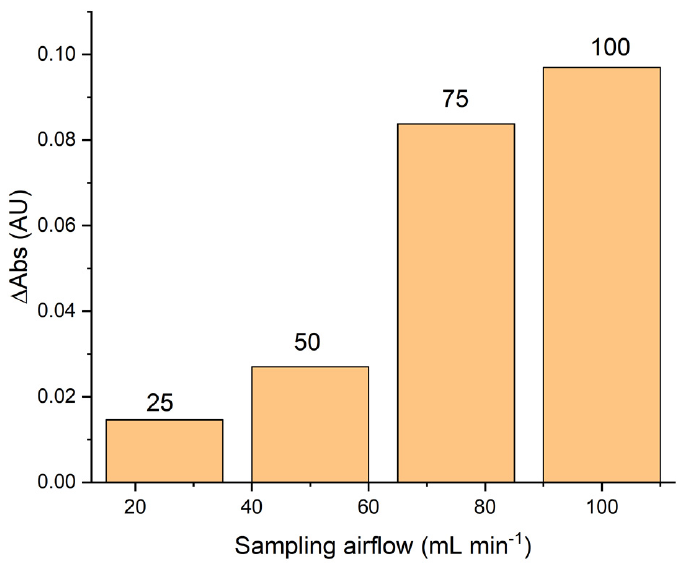
Figure 5. Effect of the sampling airflow in the analytical signal (A I -A F ).